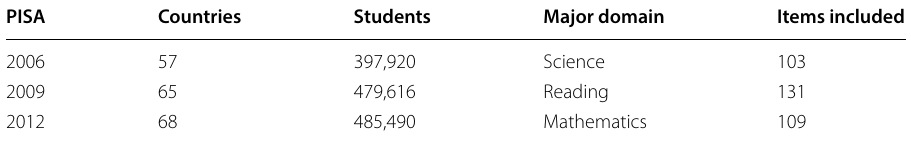
Table 1 Numbers of countries and students participating in the three PISA assessments, of which the major domains and numbers of items were included in the current study